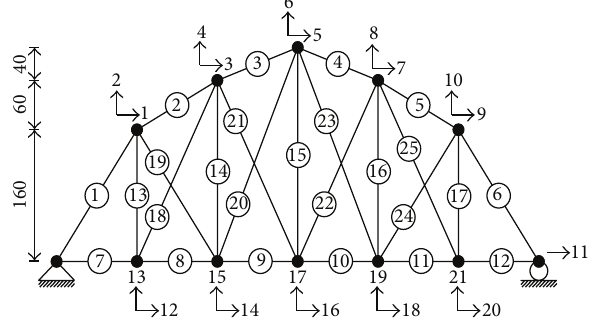
Figure 6: A 25-bar Bowstring